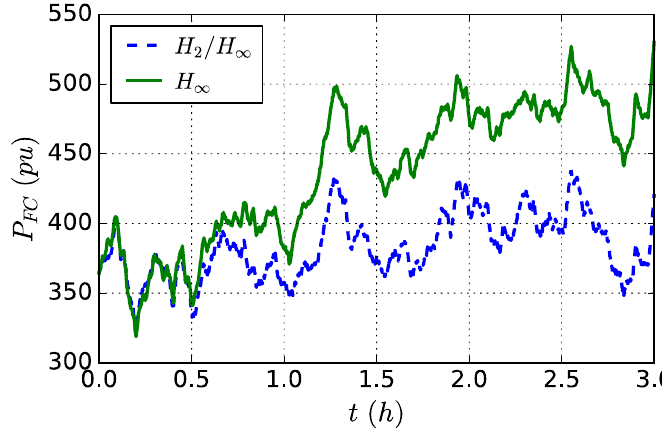
Figure 7. Power dynamics of FCs under mixed H 2 / H ∞ control and H ∞ control schemes.